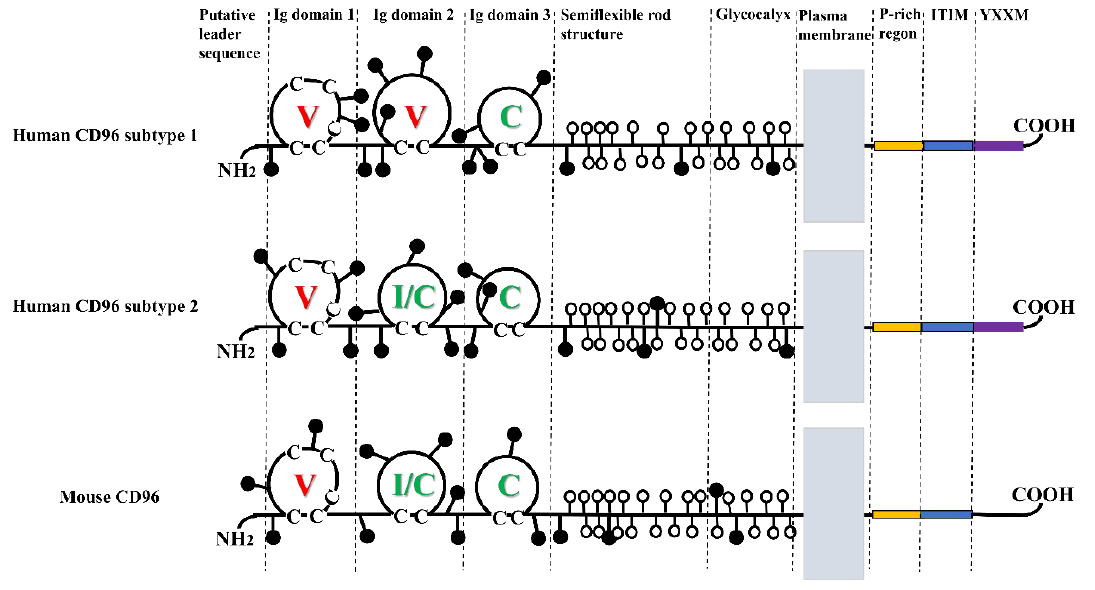
Figure 1. Molecular structure of CD96. CD96 has three Ig domains. The domain of hCD96 subtype1 is V, V, and C; the domain of hCD96 subtype2 and mCD96 is V, I/C, and C. Where the c on the domain loop refers to cysteine. N-glycosylation sites indicated by attached black circles; serines and threonines in the putative O-glycosylated region are indicated by attached open